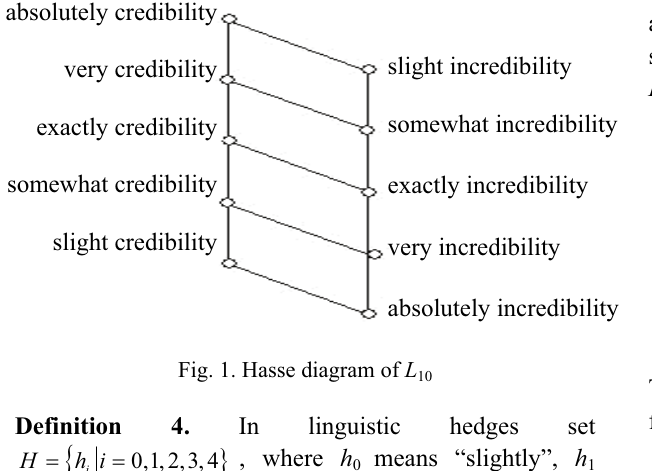
Fig. 1. Hasse diagram of L 10